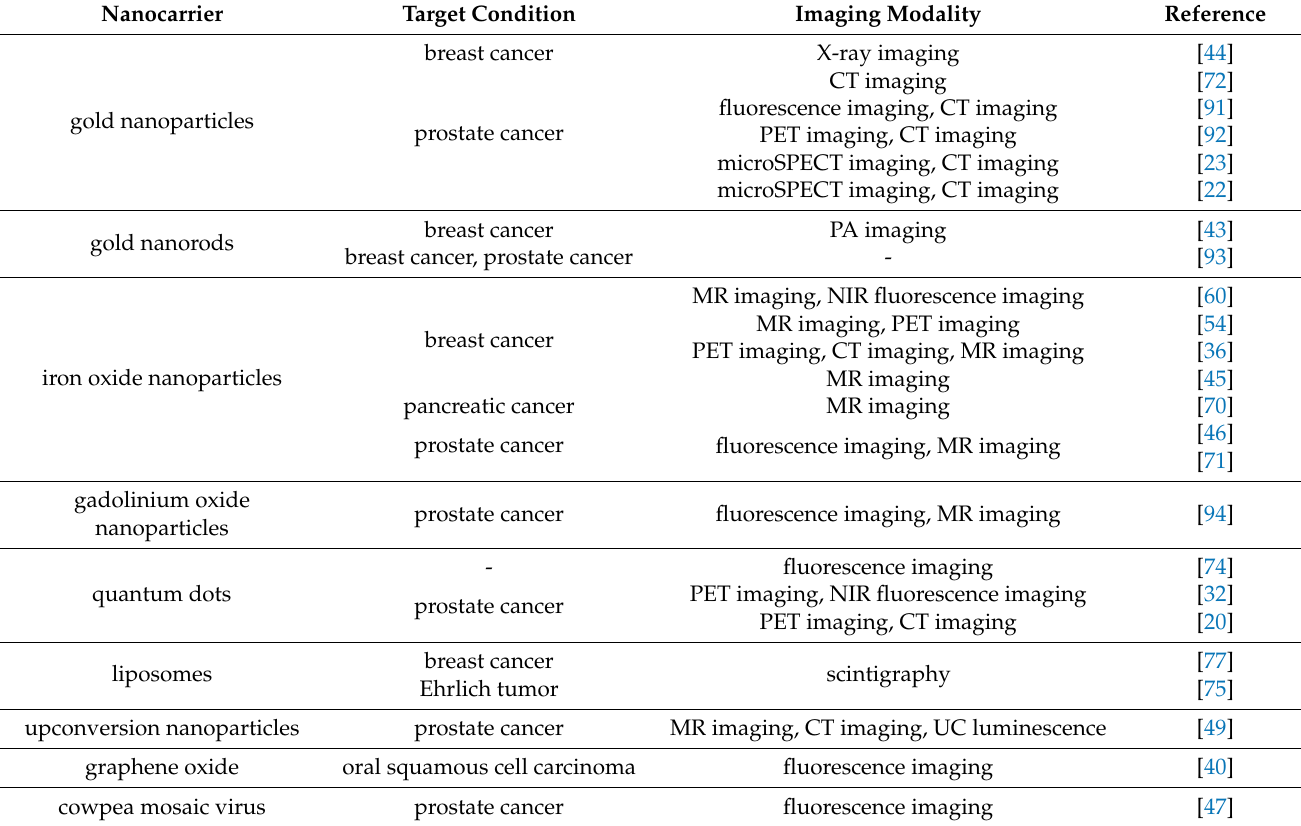
Table 2. Contemporary GRPR-targeted nanosystems for cancer